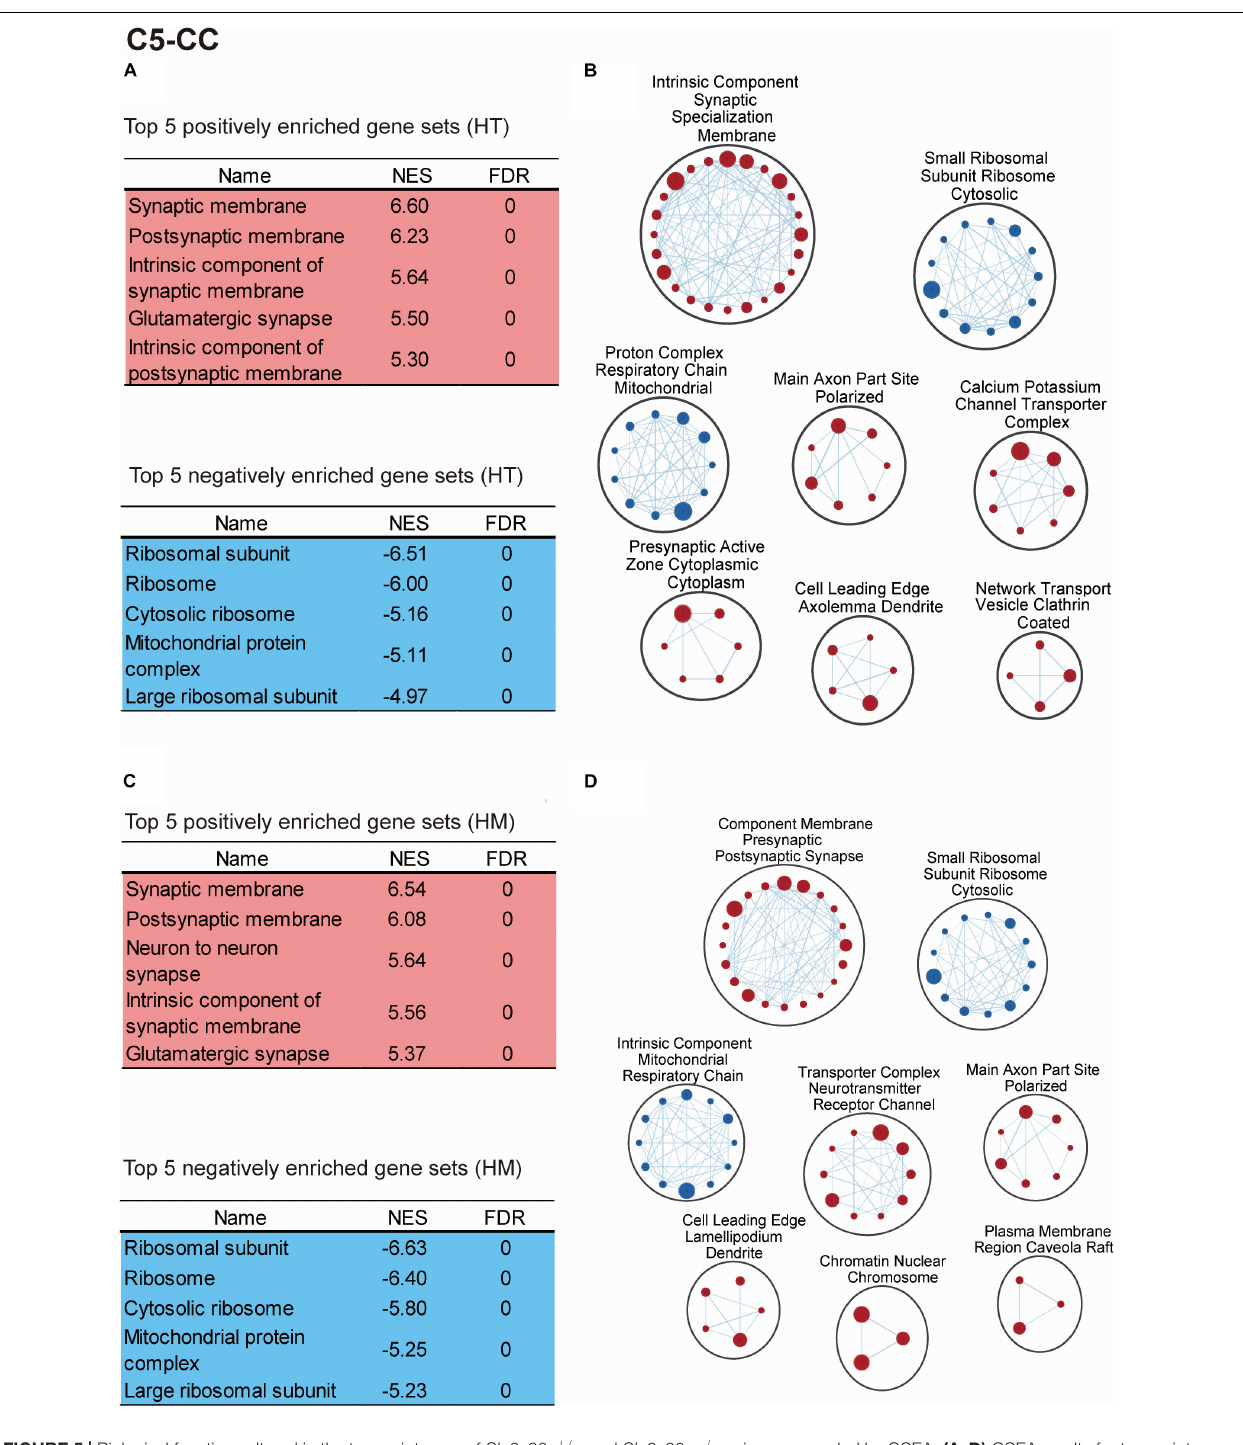
FIGURE 5 | Biological functions altered in the transcriptomes of Slc6a20a + / − and Slc6a20a − / − mice, as revealed by GSEA. (A–D) GSEA results for transcriptomes from WT and Slc6a20a + / − mice (HT/WT transcripts) and WT and Slc6a20a − / − mice (HM/WT transcripts), as shown by the top five most strongly enriched gene sets (A,C) and clustering of the enriched gene sets using CytoScape EnrichmentApp (B,D) . See Supplementary Table 4 for enriched gene sets beyond the top five genes shown in the table. Gene set clusters composed of > 3 gene sets are shown. These GSEA results were derived using the gene sets of the cellular component (CC) domain in the C5 database; see Supplementary Figures 2,3 for the GSEA results from the biological process (BP) and molecular function (MF) domains in the C5 database. NES, normalized enrichment score; FDR, false detection rate. [ n = 4 mice for WT-HT, HT, WT-HM, and HM; FDR < 0.05 (B,D) ].